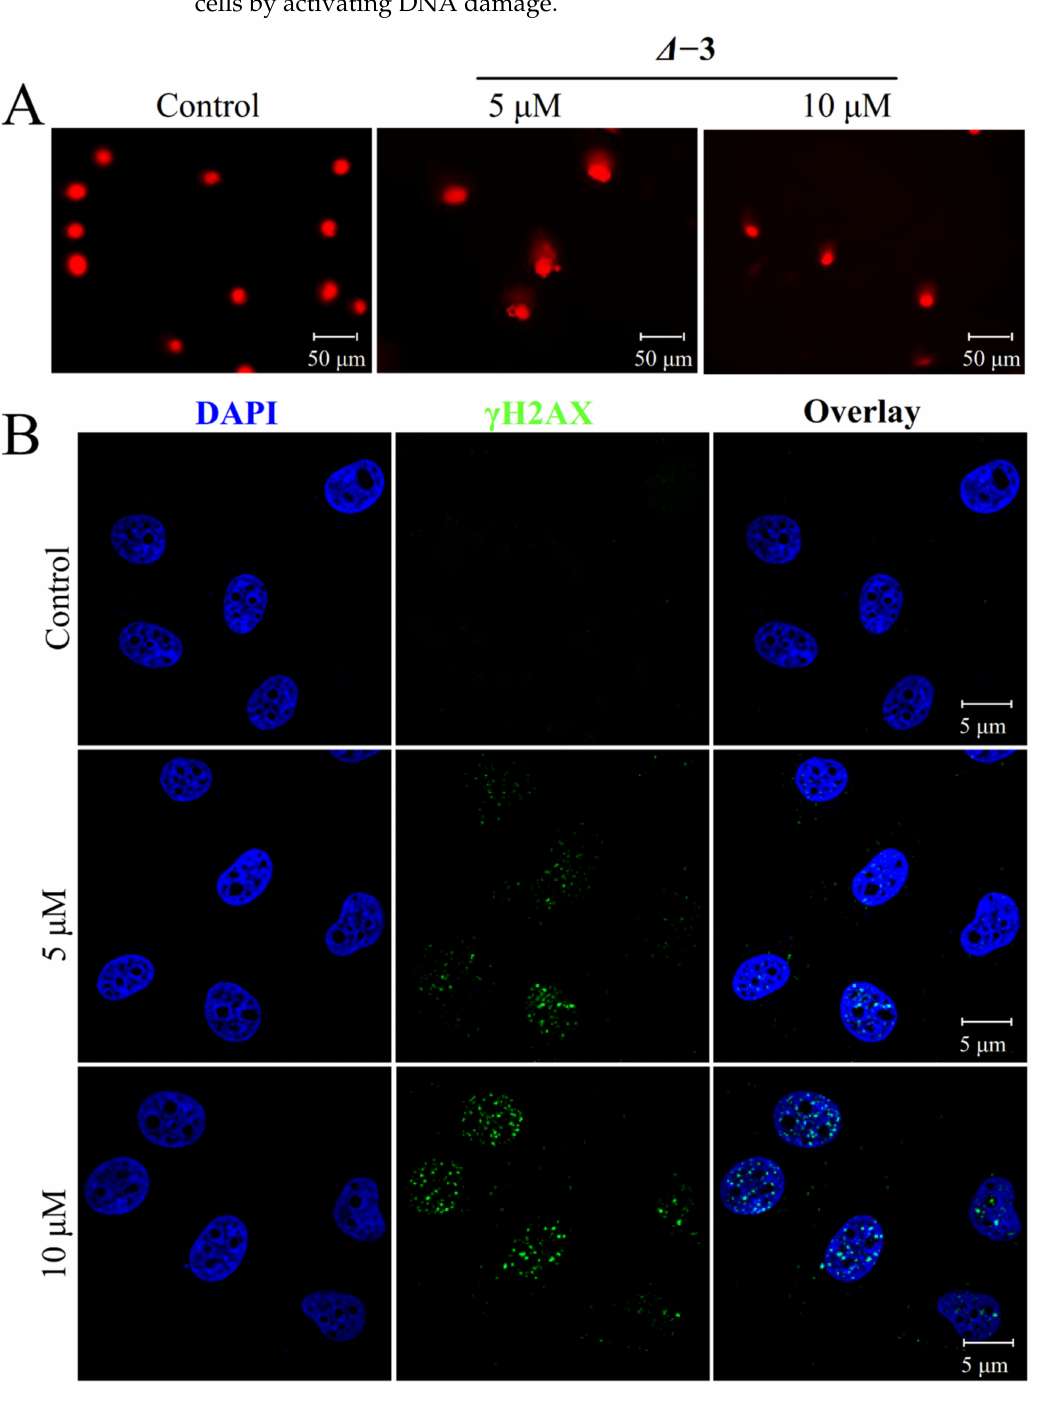
Figure 8. DNA damage induced by ∆ − 3 . ( A ) Comet assay to assess the length of tail reflecting DNA damage of MDA-MB-231 cells induced by ∆ − 3 (0, 5, and 10 µ M). ( B ) The expression level of γ H2AX in MDA-MB-231 cells treated with ∆ − 3 (0, 5, and 10 µ